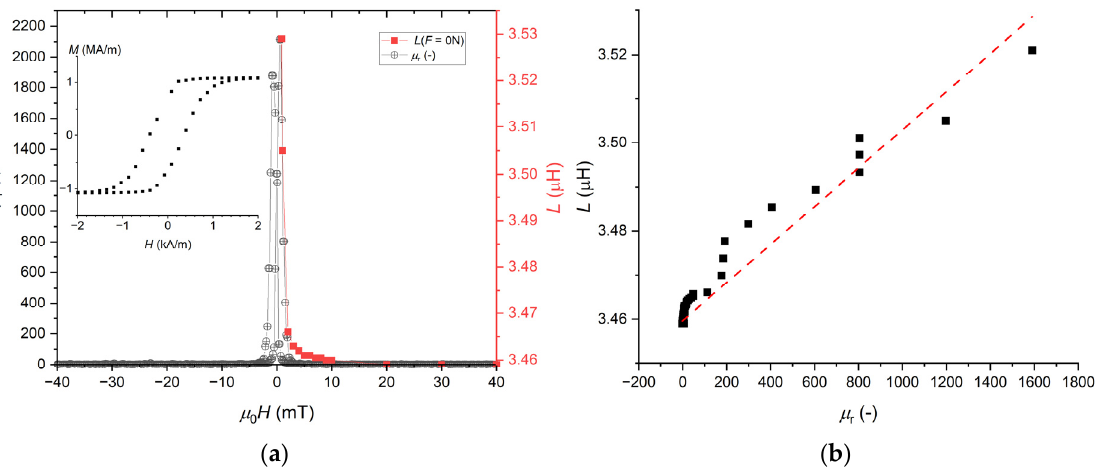
Figure 3. ( a ) Permeability obtained from the VSM (black circle) and coil inductance (red square) measured on a sample without a magnetic field; the inset shows the magnetic loop M versus H ; ( b ) Approximation of the relationship between the measured inductance to the permeability.